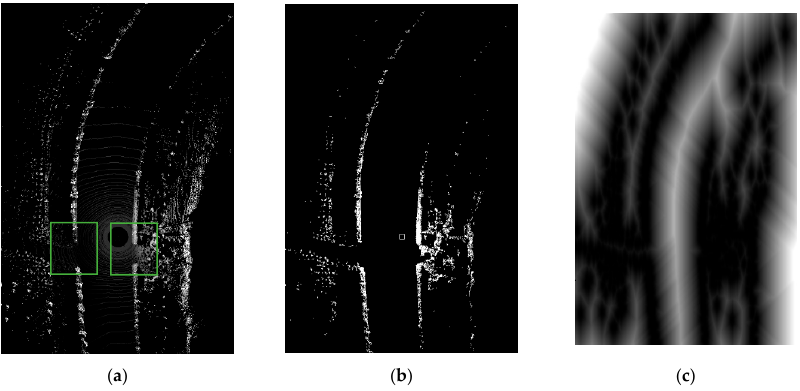
Algorithm 1. Distance Map Generation Process